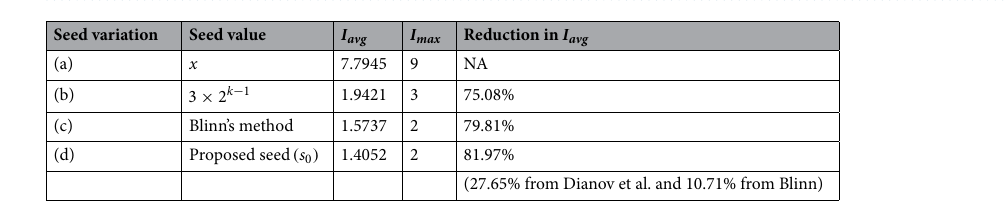
Table 9. Impact of different seed selections on the number of iterations for Bakhshali’s method using an accuracy of four decimal digits.